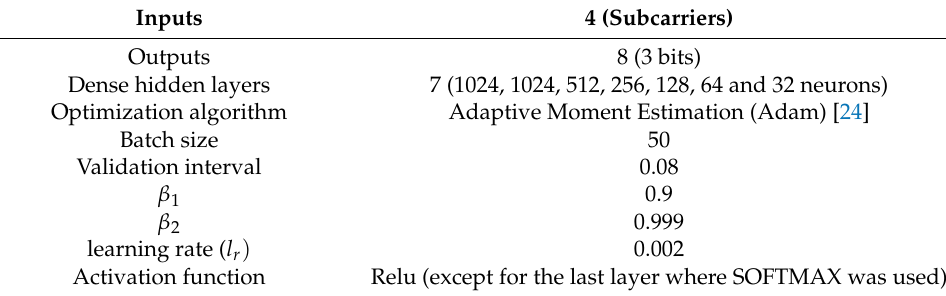
Table 1. Neural network configuration parameters.